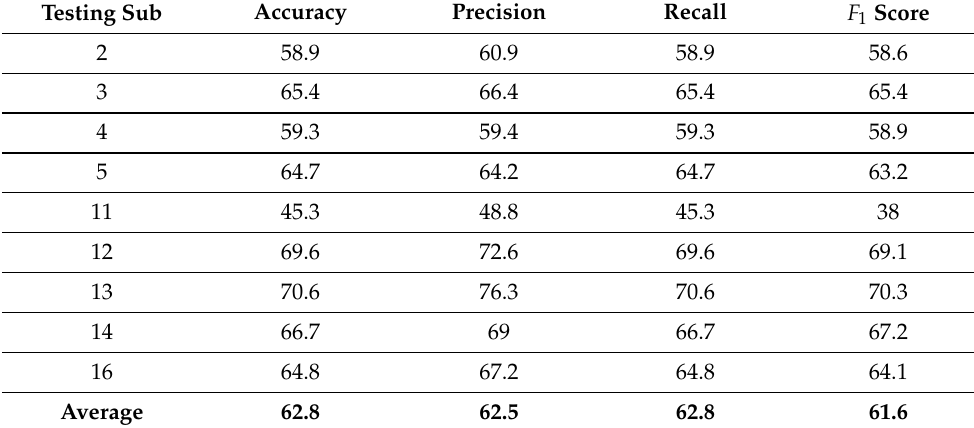
Table 4. Accuracy, precision, recall and F 1 score using 1D raw RML data with 1D CNN.